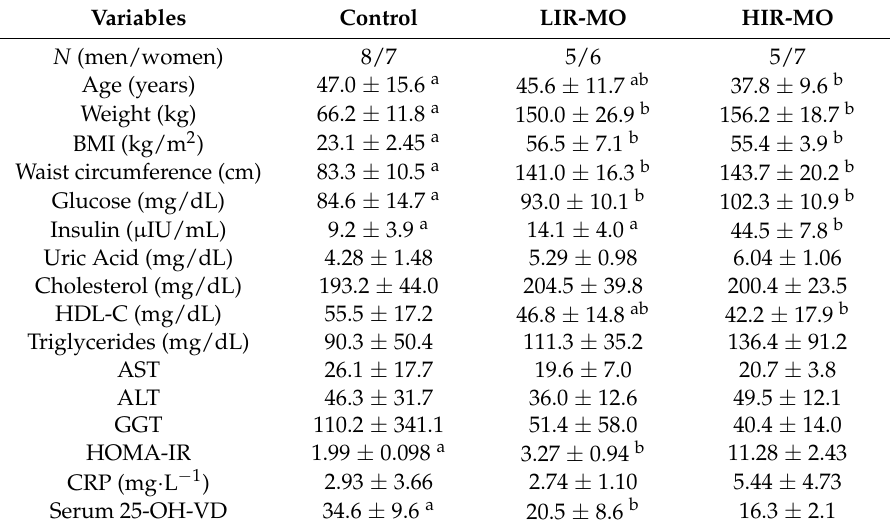
Table 1. Anthropometric and biochemical variables in control (lean) subjects, low-insulin resistance morbidly obese low insulin resistance (LIR-MO) patients, and high-insulin resistance morbidly obese (HIR-MO) patients.